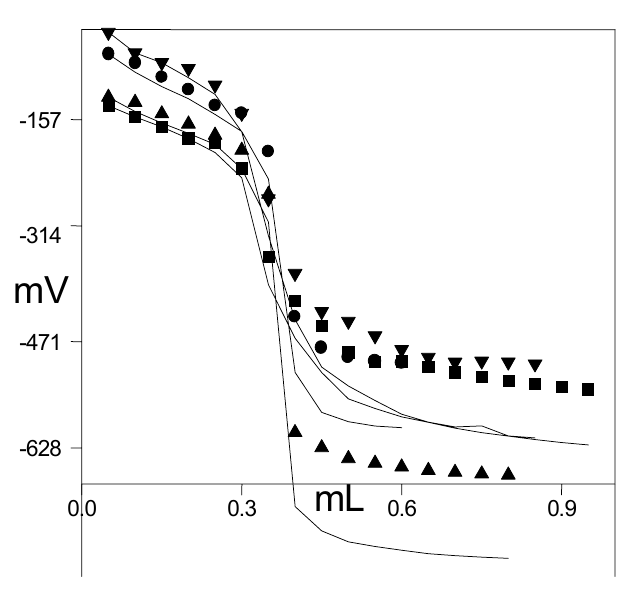
Figure 1. Potentiometric titration curves of 10 dihydro-1 H -1,2,4-triazol-5-one ( 3c ) solutions titrated with 0.05 M TBAH in isopropyl alcohol ( ● ), tert -butyl alcohol ( ▲ ), N , N -dimethylformamide ( (cid:160) ) and acetonitrile ( ▼ ) at 25